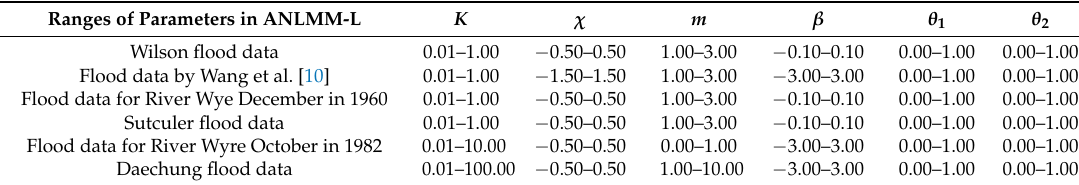
Table 1. Definition of parameters in